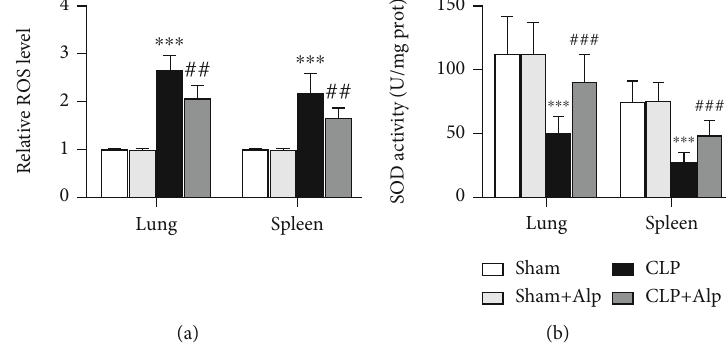
Figure 7: E ff ects of alpinetin on oxidative stress in CLP-induced PICS. After eight days, animals were sacri fi ced and the lung, liver, and kidney were removed. (a) The ROS levels in the mouse lung and spleen were assessed using commercial reactive oxygen species assay kits. (b) The SOD activity in mouse lung and spleen tissues was evaluated using commercial SOD assay kits. Sham ( n = 8 ), sham+Alp ( n = 8 ), CLP ( n = 6 ), and CLP+Alp ( n = 6 ). Data are shown as mean ± SD . ∗∗∗ p < 0 : 001 , CLP vs. sham; ## p < 0 : 01 , ### p < 0 : 001 , CLP-Alp vs. CLP.